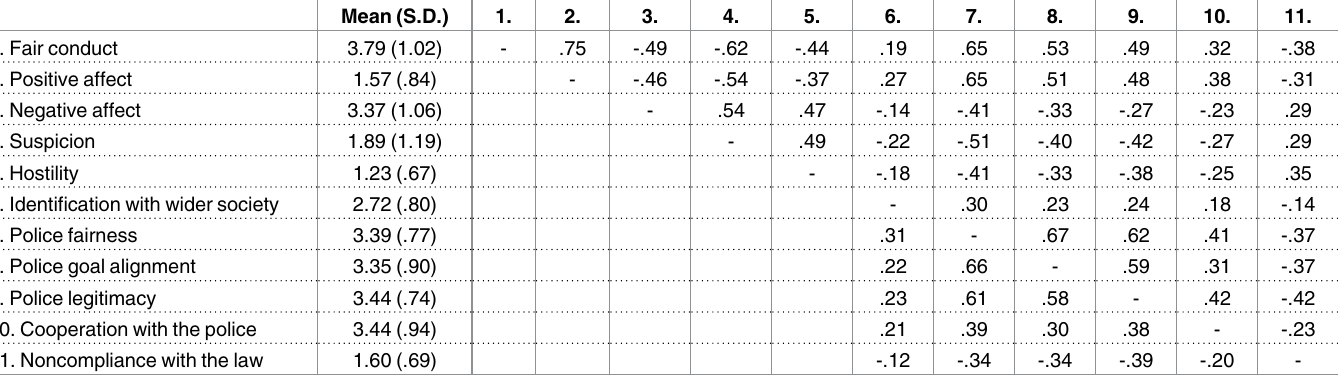
Correlations shown above the diagonal are for 664 participants reporting a direct encounter with the police. Those below the diagonal are for the full